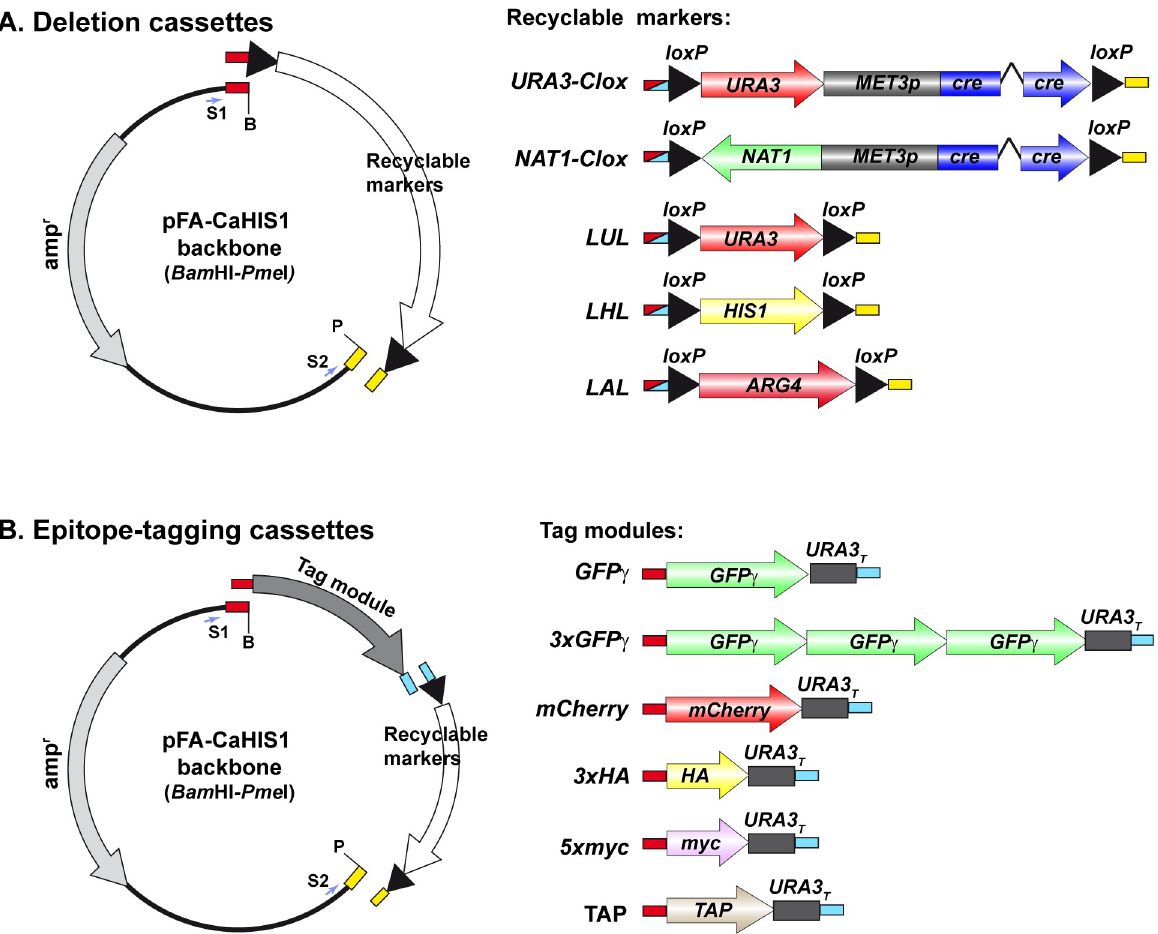
Fig 1. Modular strategy used for the construction of pFA plasmids with recyclable markers. (A) Construction of pFA deletion plasmids. The five recyclable markers flanked by loxP repeats were amplified with oligonucleotides LXL1 and LXL2, which generated overlapping ends with the pFA-CaHIS1 backbone digested with Bam HI and Pme I. The amplified fragments were assembled with the vector in 5 independent reactions using NEBuilder HiFi DNA Assembly kit. (B) Construction of epitope-tagging plasmids. The different tagging modules (GFP γ , 3xGFP γ , mCherry, 3xHA, 5xmyc or TAP-TAG) were amplified with oligonucleotides that generated overlapping ends with the pFA-CaHIS1 backbone digested with Bam HI (red) and with the 5´end of the recyclable marker module (light blue). The five recyclable markers were independently amplified with oligonucleotides that produced DNA fragments containing overlapping ends with the tagging modules (light blue) and the pFA-CaHIS1 backbone digested with Pme I (yellow). The different modules were assembled with the vector in independent reactions using NEBuilder HiFi DNA Assembly kit.